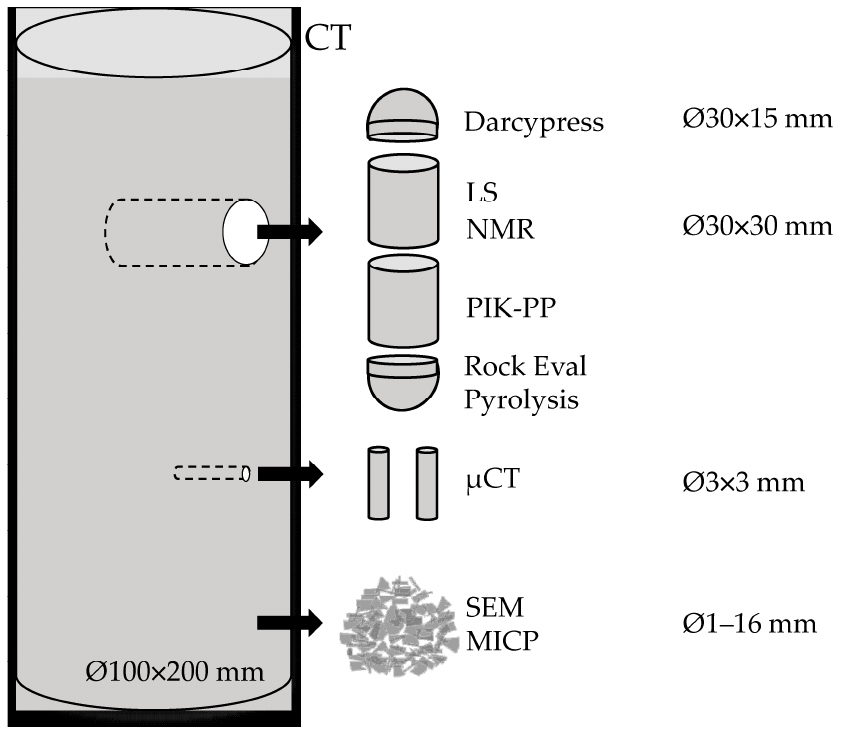
Figure 5. Schematic diagram of the whole-core breakdown into